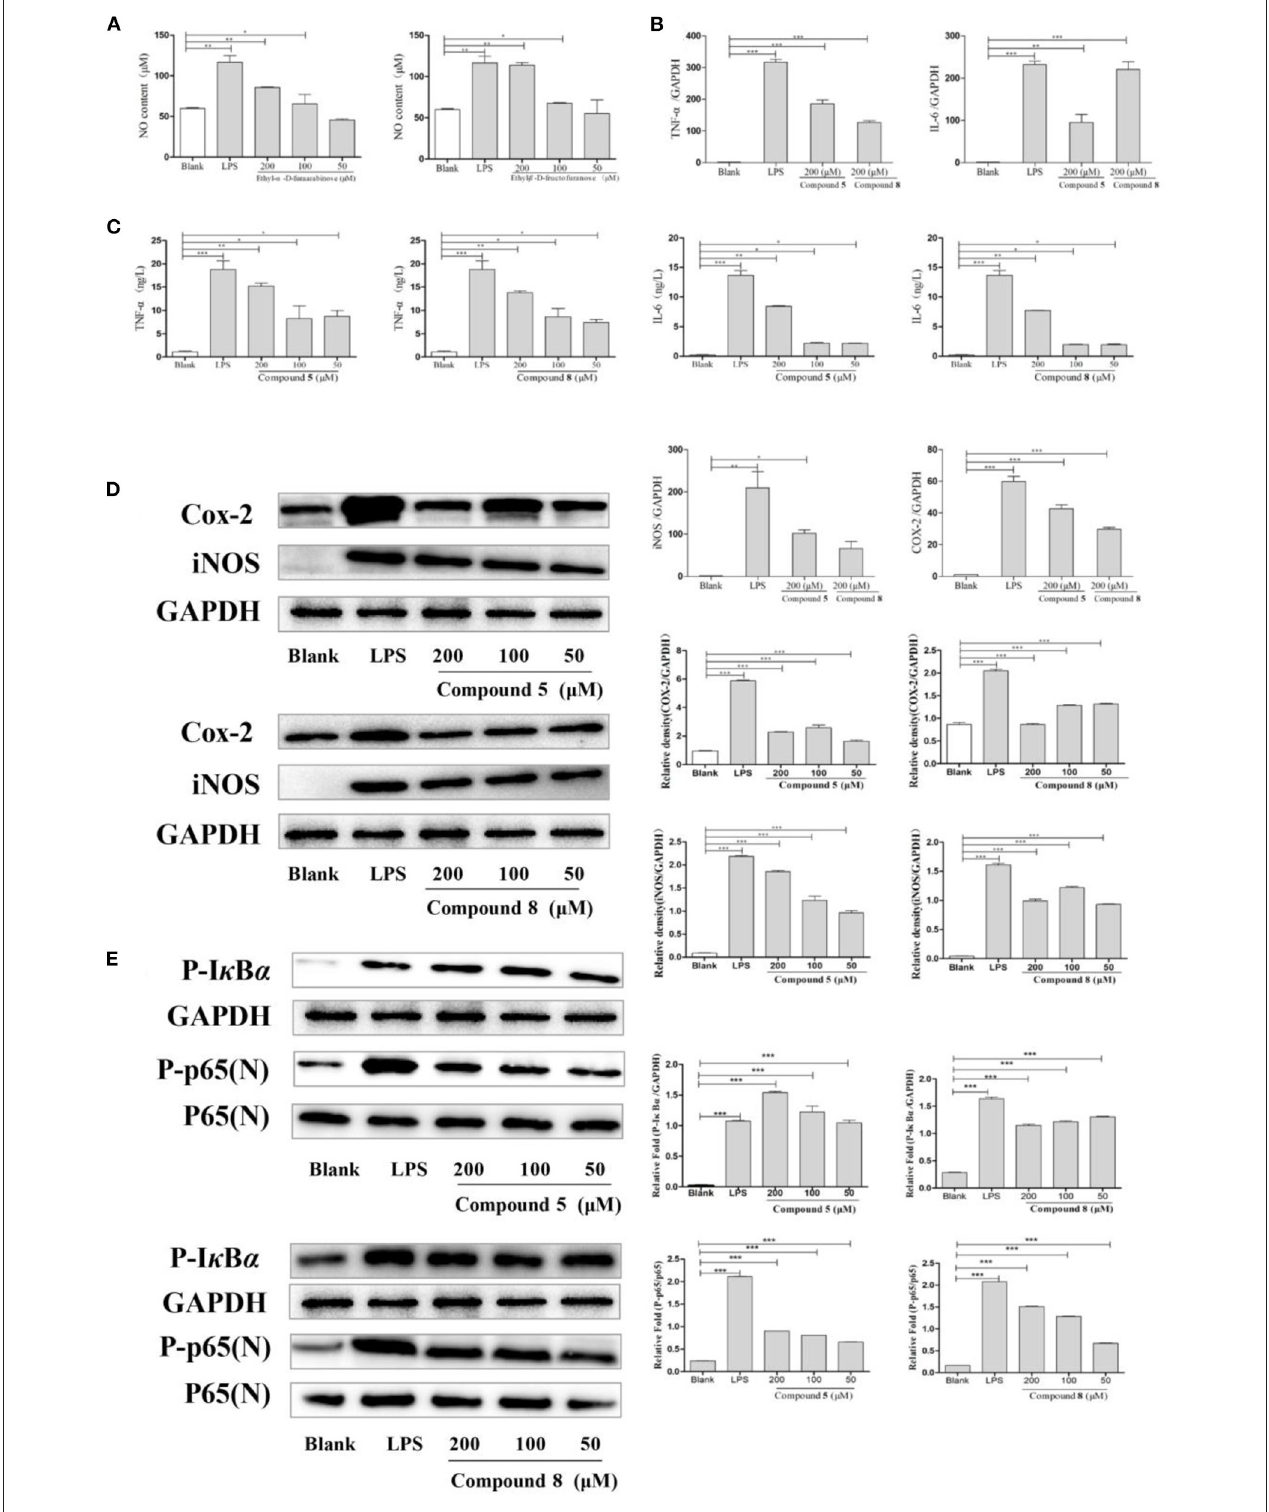
FIGURE 4 | Effects of compounds 5 and 8 on the nuclear factor- κ B (NF- κ B) signaling pathways in normal cultured RAW264.7 cells. (A) Expression of nitric oxide (NO) production. (B) Inflammatory cytokine tumor necrosis factor- (TNF-) α , interleukin- (IL-) 6 mRNA transcription. (C) Secretion of TNF- α , IL-6. (D) mRNA and protein expression of cyclooxygenase- (COX-) 2 and inducible nitric oxide synthase (iNOS). (E) Expression of key proteins in the NF- κ B signaling pathways. Glyceraldehyde-3-phosphate dehydrogenase (GAPDH) served as control. Data shown are means ± SEM. *** p < 0.001, ** p < 0.01, * p < 0.05.